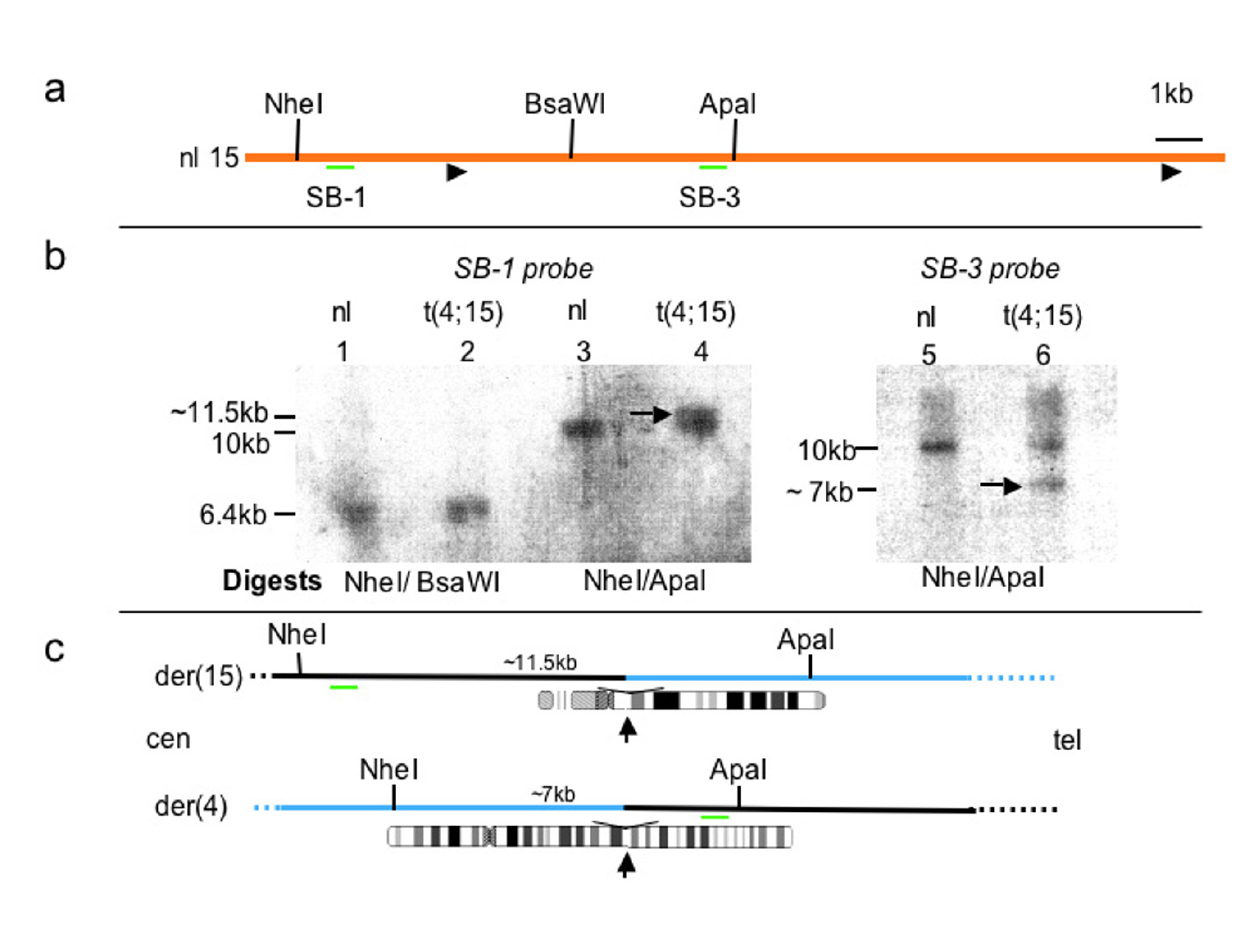
SNRPN gene on the normal chromosome 15. Black arrowheads indicate the boundaries of intron 17. The positions of the two hybridization probes (SB-1 and SB-3) are indicated by green lines. b . Lanes 1 and 2 contain double digests with Nhe I and BsaW I membrane was probed with probe SB-1. The arrow indicates an additional band above the 10 kb fragment ~11.5 kb in length. The two bands are not well resolved on the rendition of this blot. This novel fragment is represented in c, upper panel. Lanes 5 and 6 contain double digests with Nhe I and Apa I to release a 10 kb fragment. The membrane is probed with SB-3. The arrow indicates an additional band of ~ 7 kb. This novel fragment is represented schematically in c, lower panel. c . Schematic repre- sentation of the junction fragments identified on the Southern blot in b. The upper panel represents the der(15) and the lower panel represents the der(4). Chromosome 15 material is indicated as a black line and material from chromosome 4 as a blue line. Location of restriction sites and of hybridization probes (green lines) are